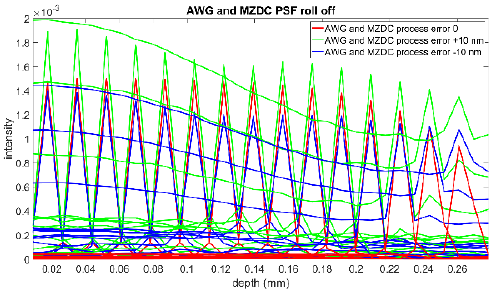
Figure 13. The point spread function only from the bidirectional MZDC with ED compensation.